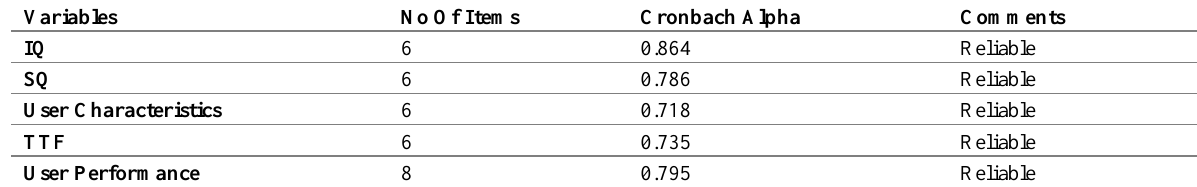
Table 1: Results of